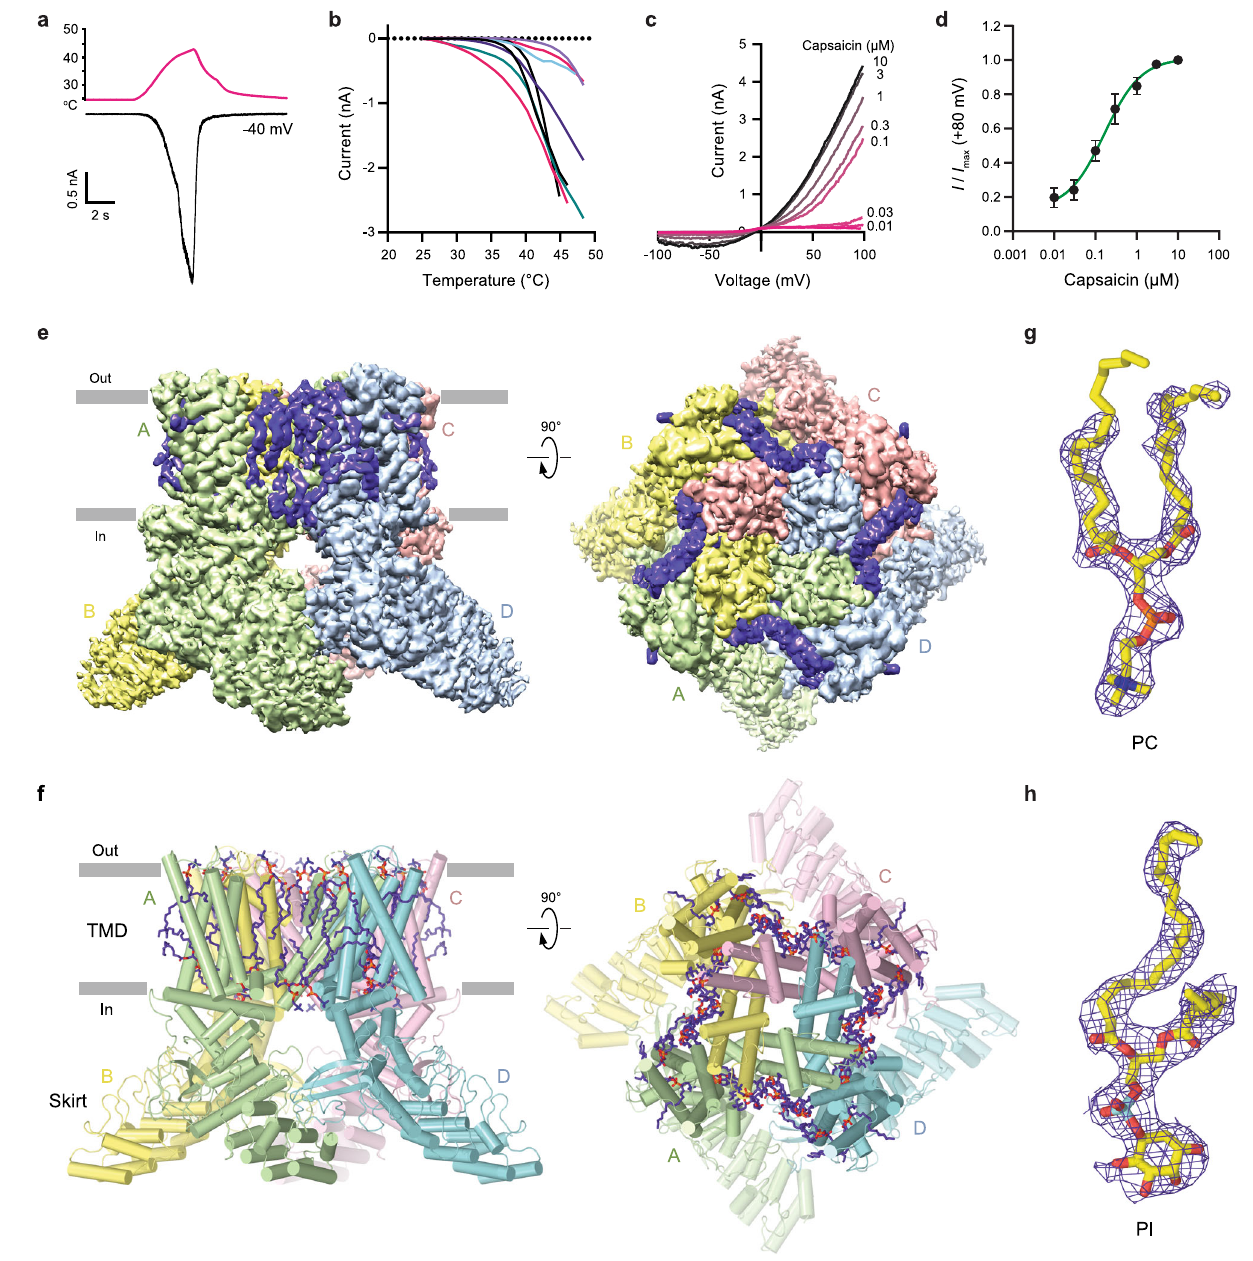
Fig. 1 | Apo-state structure of human TRPV1. a Representative current trace obtained at – 40mV in response to a temperature ramp from 25°C to 45°C recorded in the whole-cell mode from an HEK 293 cell expressing hTRPV1. b Current-temperature dependence obtained from recordings as in a showing temperatureactivationofhTRPV1. c Exemplarwhole-cellcurrenttracesevokedbya voltagerampinHEK293cellsexpressinghTRPV1bycapsaicinfrom0.01to10 µ Mat 25°C. d Concentration-dependenceofhTRPV1activationbycapsaicinmeasuredat +80mV and normalized to the current at 10 µ M of capsaicin. Data are shown as